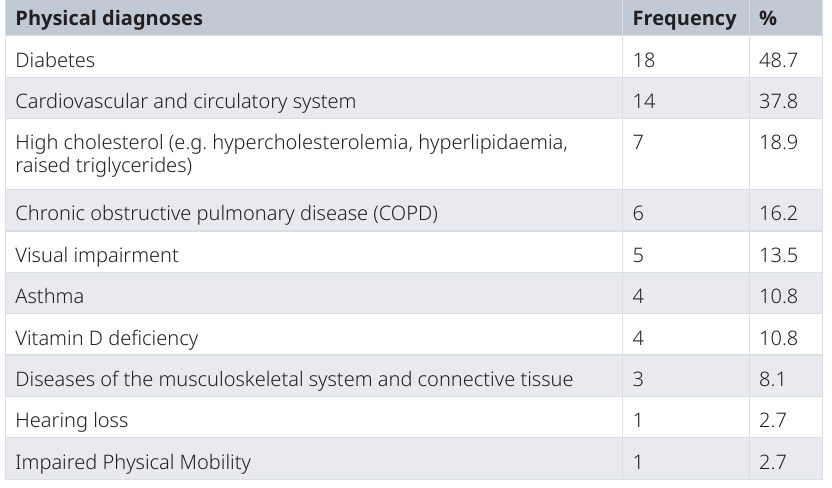
Table 4. Physical health burden of the sample.